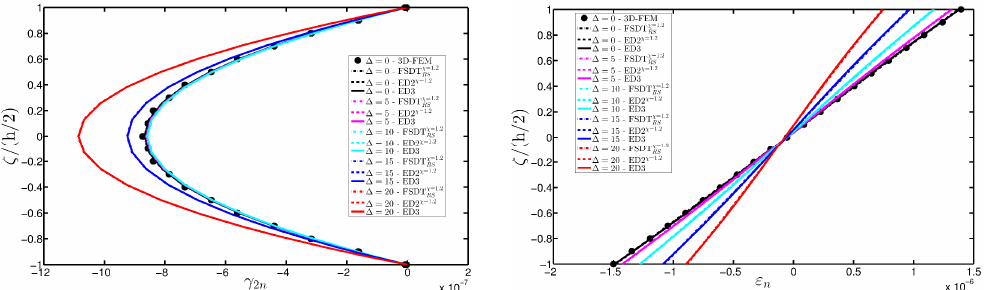
Figure 10. Through-the-thickness profiles of strain components for the CCCC isotropic square plate computed at the point A for different HSDTs. The effect of the damage is investigated by varying the parameters of the function Gau-3.